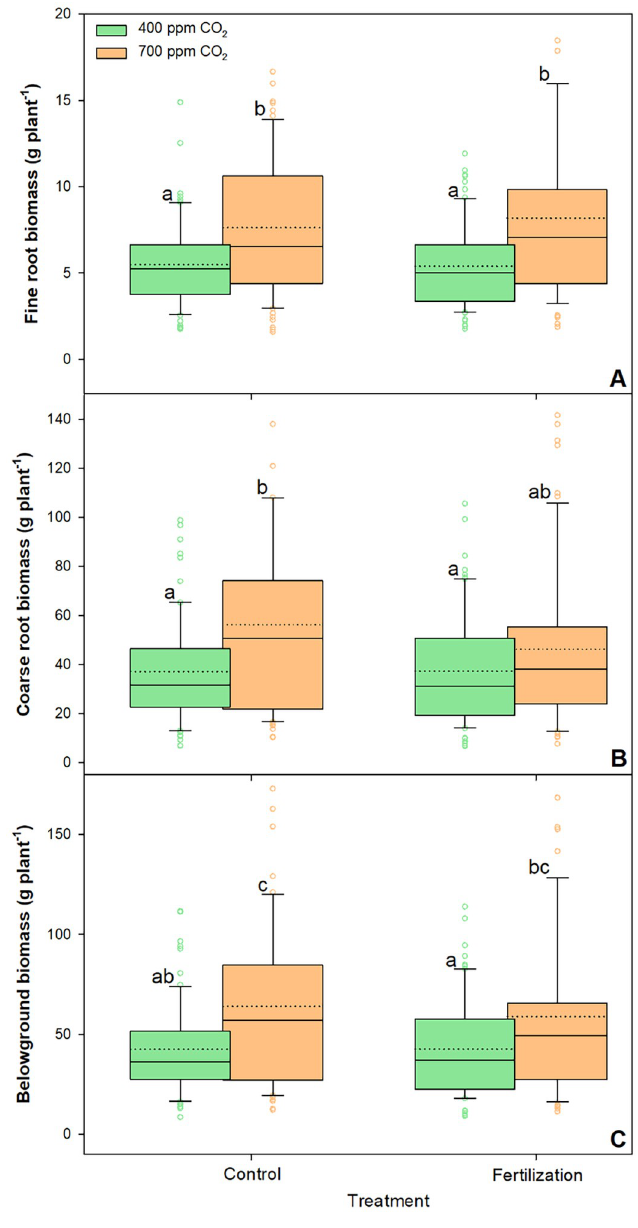
Fig 3. Changes in fine roots biomass (A), coarse roots biomass (B), and belowground biomass (C) of sessile oak saplings (n = 72) treated under ambient (400 ppm CO2) and elevated (700 ppm CO2) and different nutrient supplies. The data are expressed as medians (solid lines) and means (dotted lines) of measurements. The box boundaries mark the 25th and 75th percentiles and whiskers the 10th and 90th percentiles. Circles mark outliners. Different letters indicate significant differences (p � 0.05) estimated on the basis of Duncan’s ANOVA post-hoc